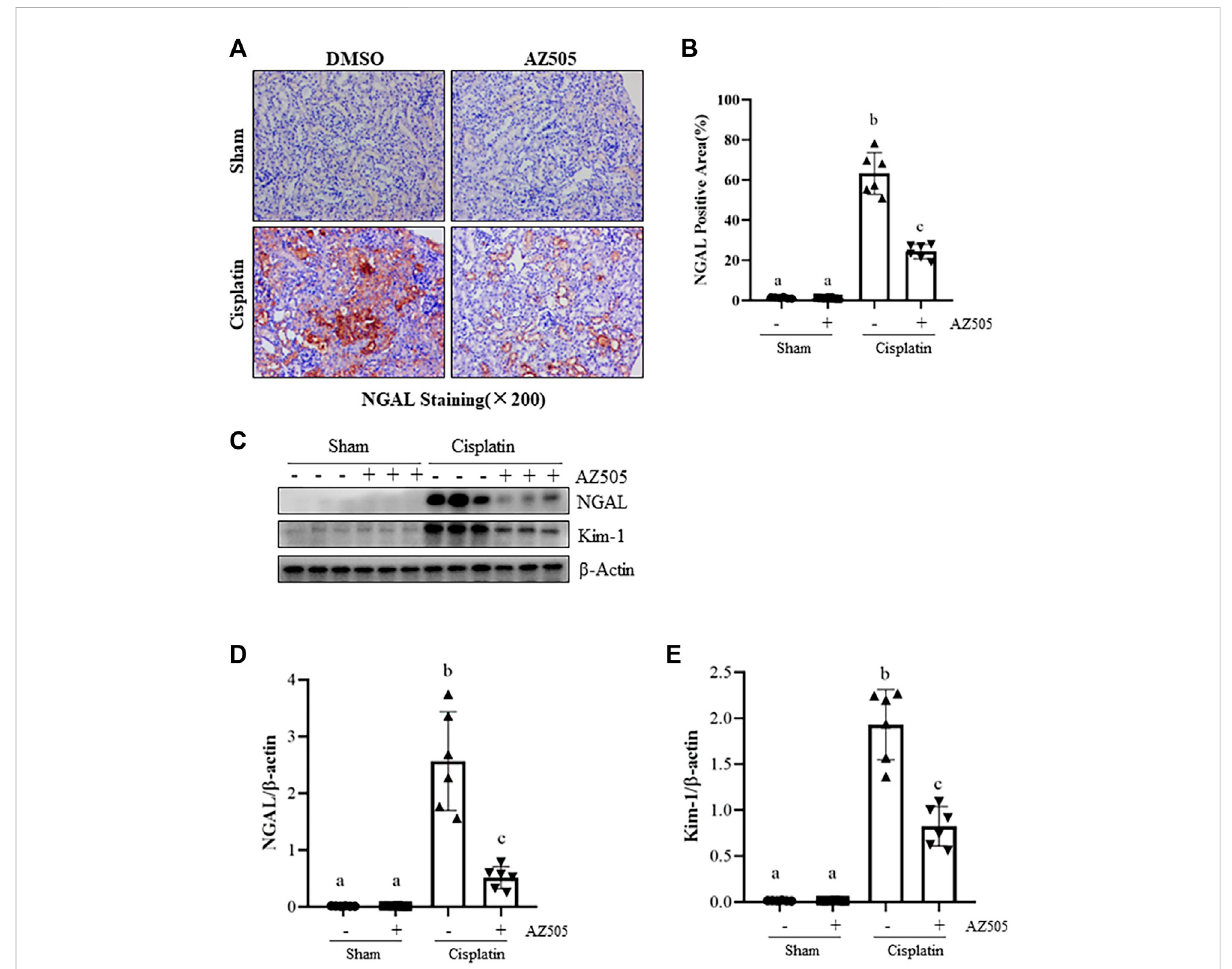
FIGURE 3 AdministrationofAZ505amelioratescisplatin-inducedkidneytubularinjury. (A) Photomicrographsillustrateimmunohistochemicalstainingfor NGAL of the kidney tissues with or without AZ505 treatment (×200). (B) The graph shows the percentage of NGAL-positive areas (brown) relative to the whole area from 10 random cortical fi elds (×200). (C) The kidney tissues were taken for immunoblot analysis of NGAL, Kim-1 and β -Actin as indicated. Representative immunoblots from 3 experiments are shown. (D,E) Expression levels of NGAL (D) and Kim-1 (E) were quanti fi ed by densitometry and normalized with β -Actin as indicated. Data are means ± S.E.M ( n = 6). Means with different superscript letters are signi fi cantly different from one another ( p <